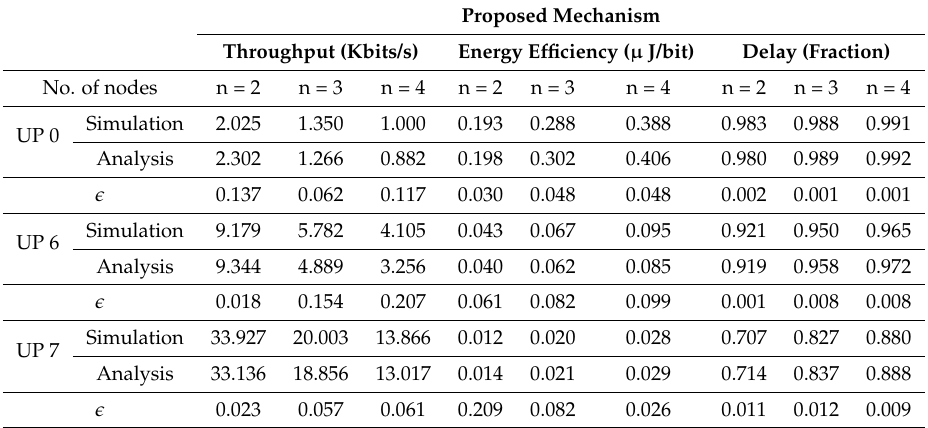
Table 4. Comparison of simulation and analytical results for the proposed mechanism.